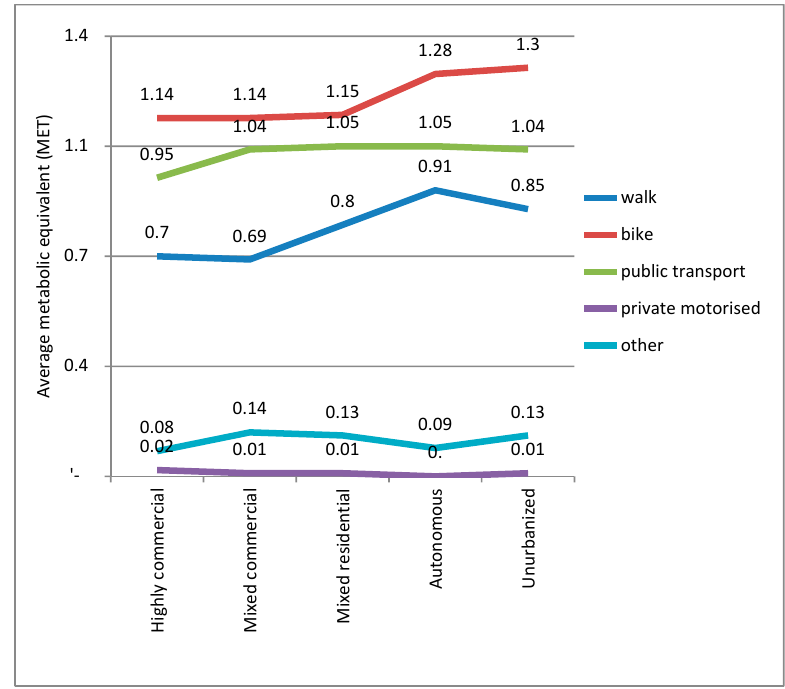
Figure 6. The average MET hours by mode and built environment type.